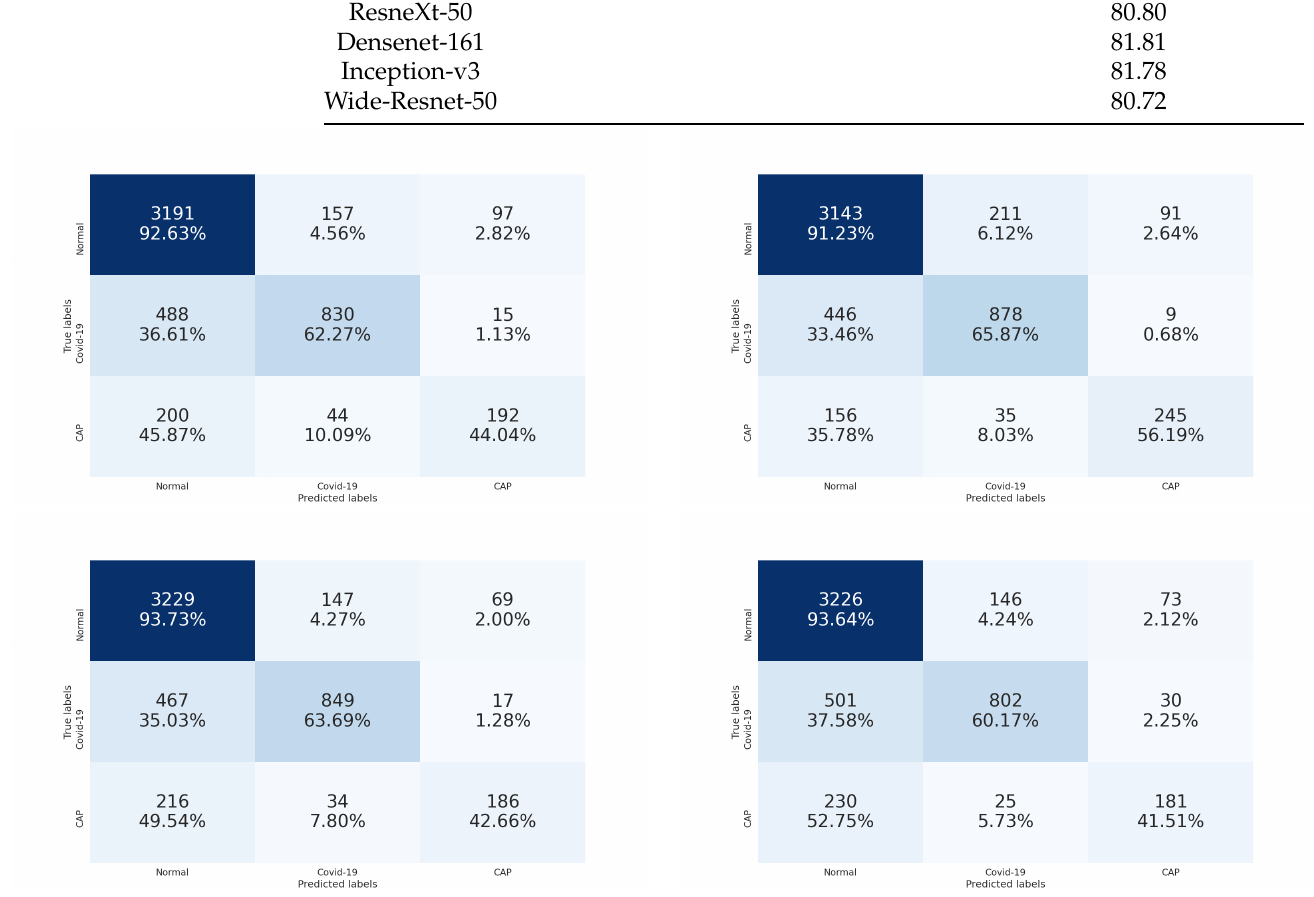
Figure 6. Confusion matrices of the stacked grayscale images on validation data using ResneXt-50, Inception-v3, DenseNet- 161, and Ensemble-CNNs, respectively. The vertical axis is for the true classes, and the horizontal axis is for the pre- dicted